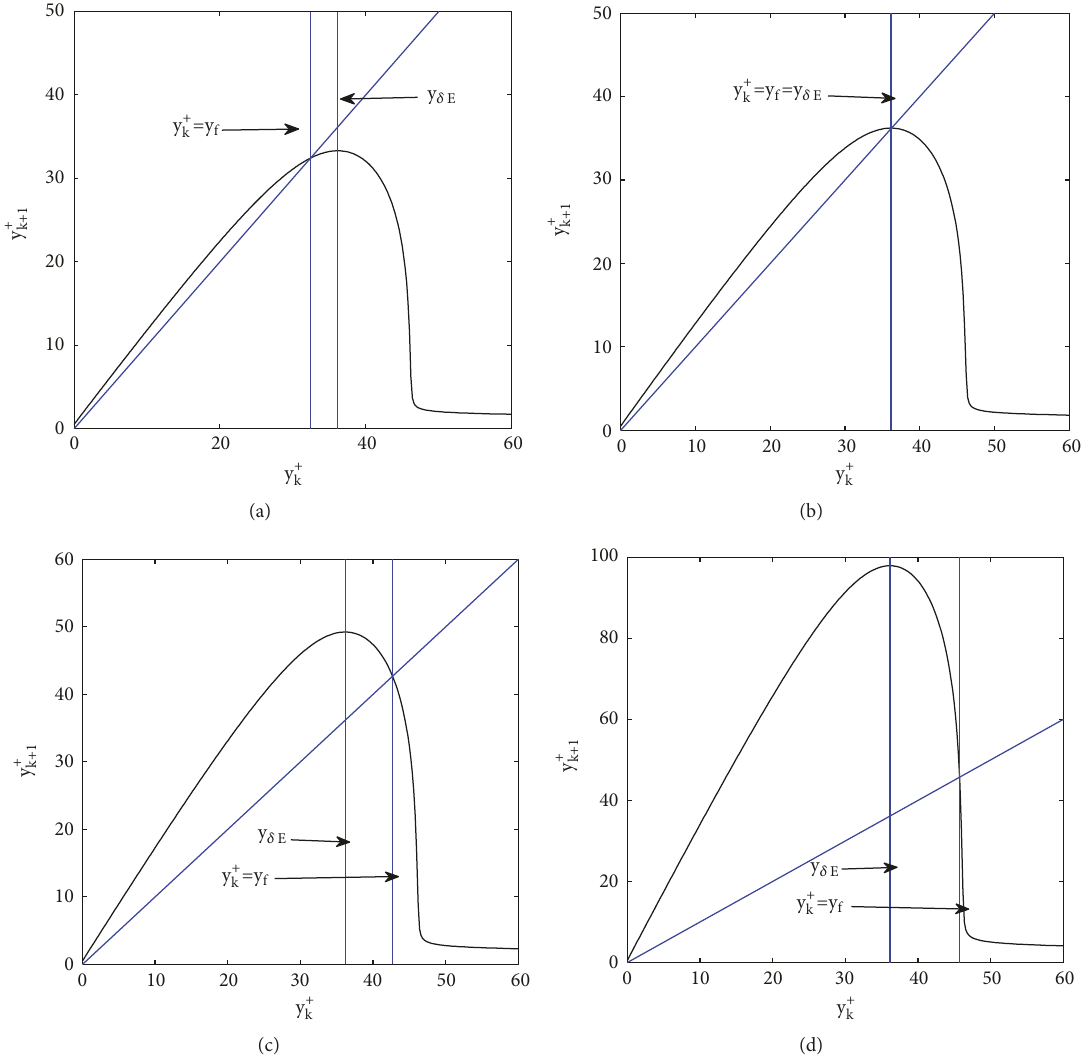
Figure 1: The Poincar´e map 𝜑 and its fixed point 𝑦 𝑓 . All parameter values were fixed as 𝑟 = 0.5 , 𝐾 = 50 , 𝑚 = 0.15 , 𝐴 = 0.5 , 𝑠 = 0.05 , ℎ = 0.7 , 𝐸𝑇 = 30 , 𝛿 = 0.5 , and 𝜎 = 0.5 . (a) 𝑞 = 0.01 ; (b) 𝑞 = 0.1 ; (c) 𝑞 = 0.5 ; (d) 𝑞 = 2